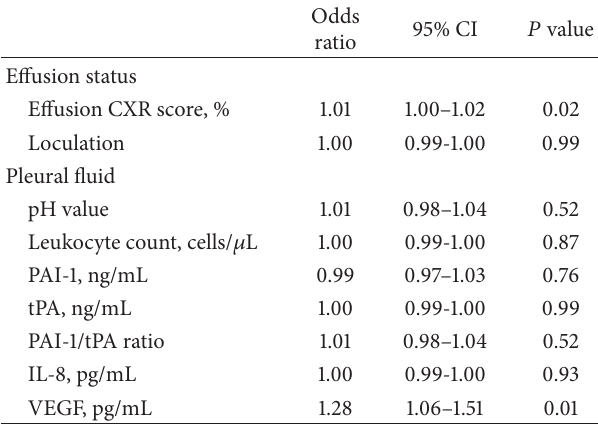
Table 5: Multivariate logistic regression analyses of factors associ- ated with residual pleural thickening